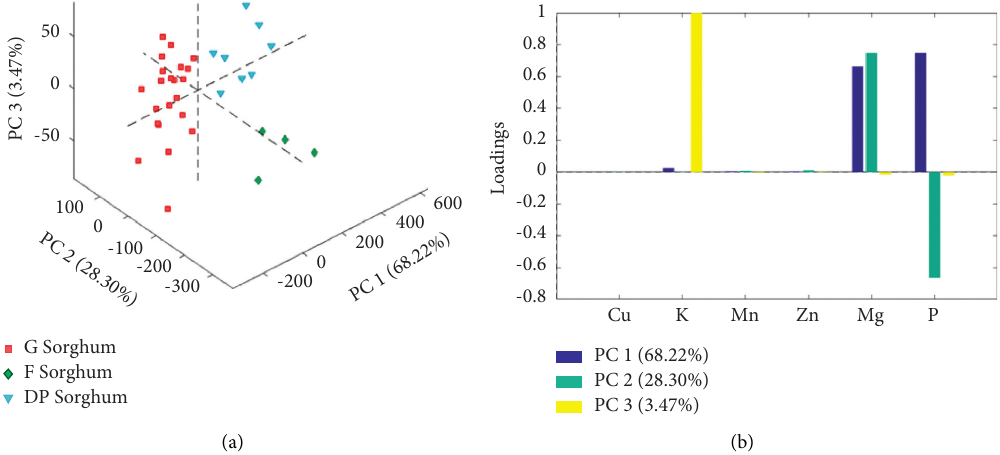
Figure 3: (a) Score scatter plots of the first 3 PCs obtained from PCA applied to a dataset corresponding to each mineral content on sorghum samples. The samples are shown according to the hybrids: G sorghum samples (red square), F sorghum samples (green diamond), and DP sorghum samples (light-blue triangle). Explained variance values of PC1, PC2, and PC3 are displayed in the corresponding axis. (b) Loading bar plots of the first 3 PCs obtained from PCA for each